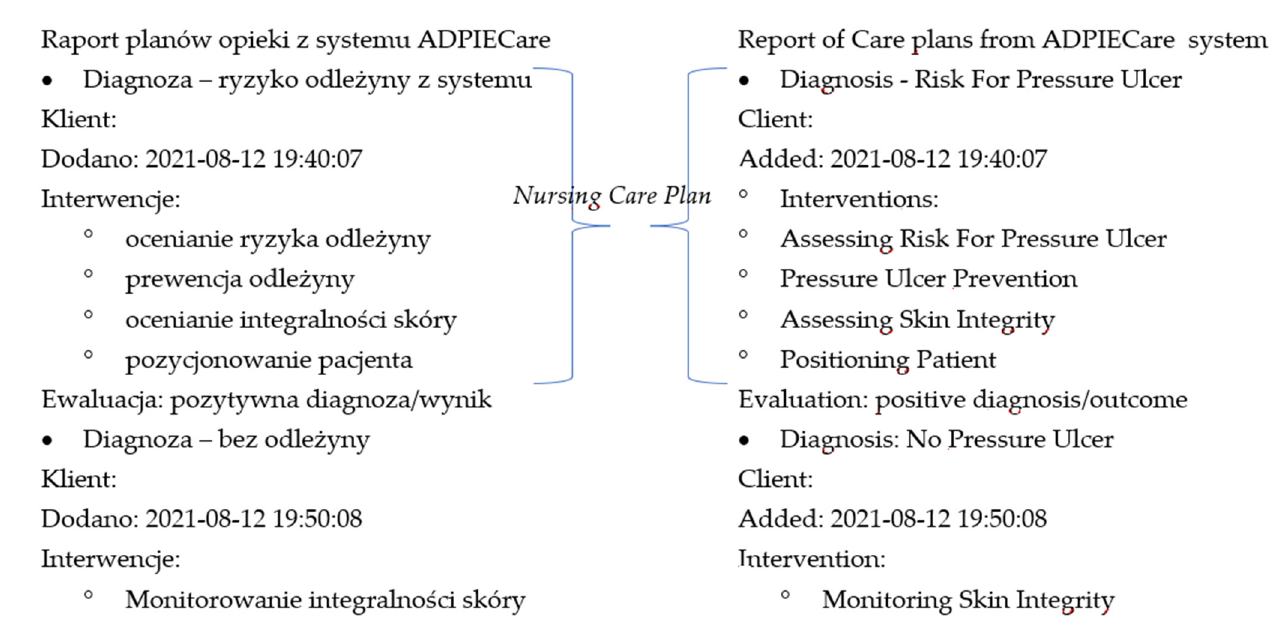
Figure 2. The nursing care plan report from the ADPIECare system, Availaible online http://ciitt.umed.pl/system-dokumentacji-i-wsparcia-prac-pielegniarskich-adpiecare-dorothea/ (accessed on 9 January 2022).